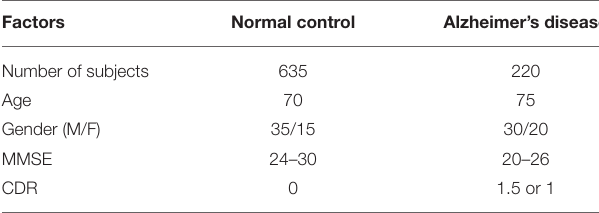
TABLE 1 | Demographic details of 18FDG-PET image dataset.